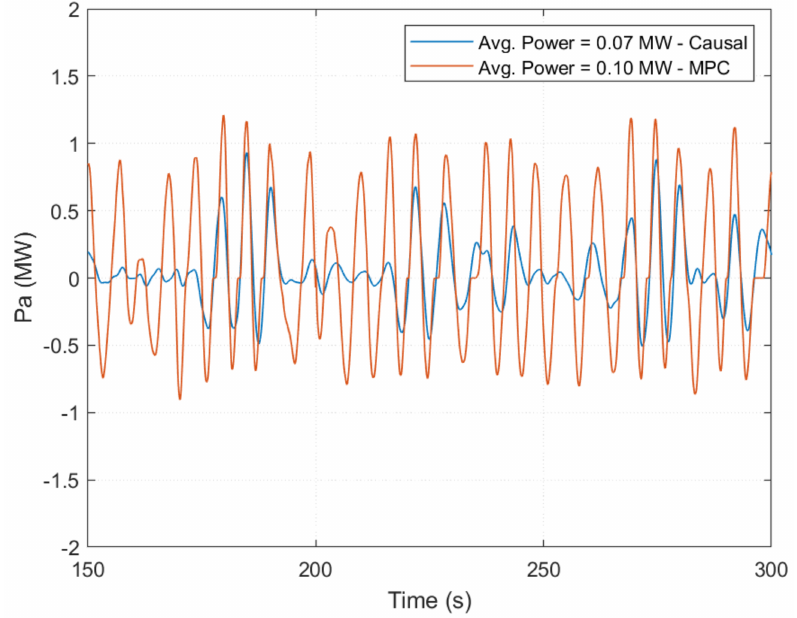
Figure 11. Comparison of average power using causal control vs. MPC for an input wave with Hs = 1.0 m, Tp = 15